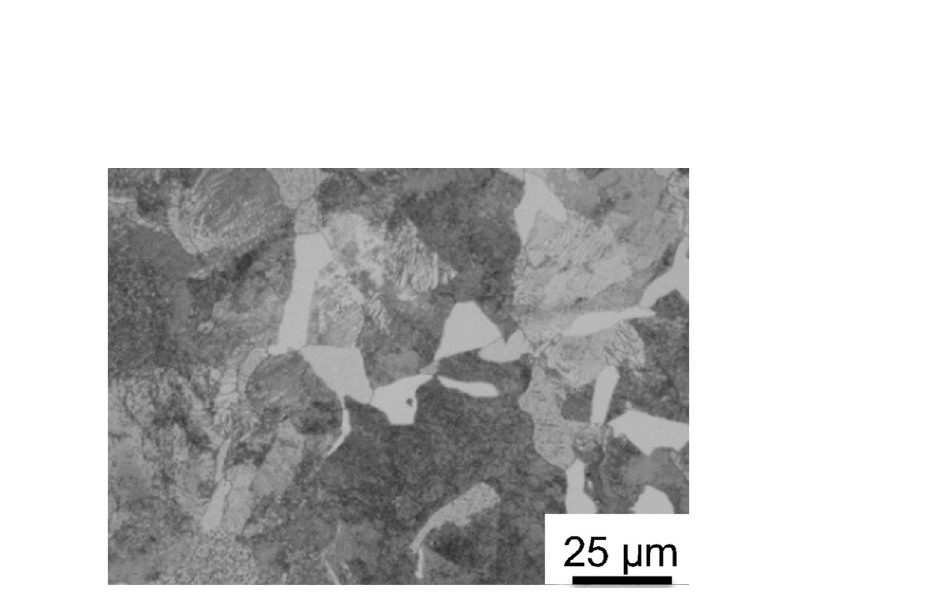
Figure 4. Initial microstructure prior to heat treatment of test gears, showing ferrite in grey color and pearlite in black